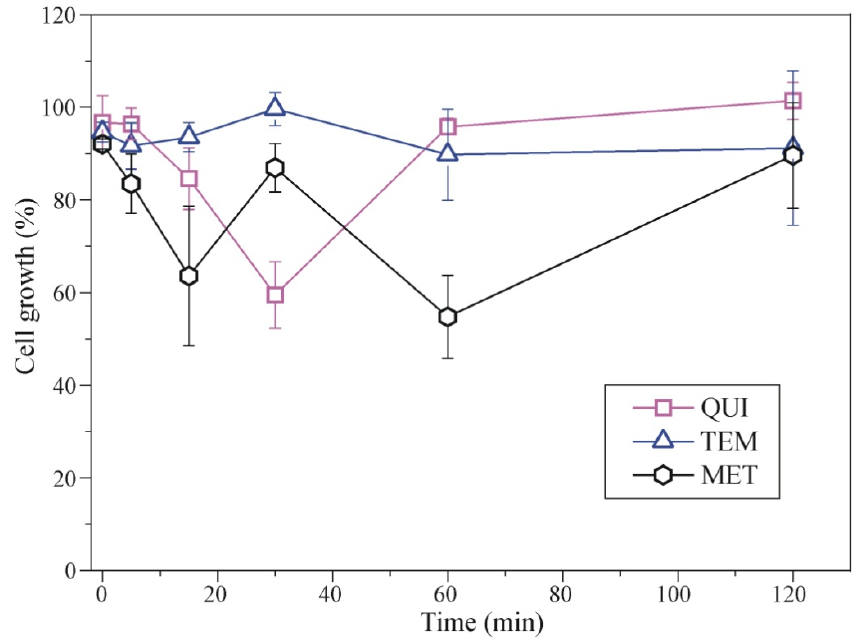
Figure 10. Effect of reaction mixtures of QUI, TEM, and MET (0.05 mmol/dm 3 ) using TMO (1.0 mg/cm 3 ) and formed intermediates after different irradiation times on the growth of the H-4-II-E cell line.